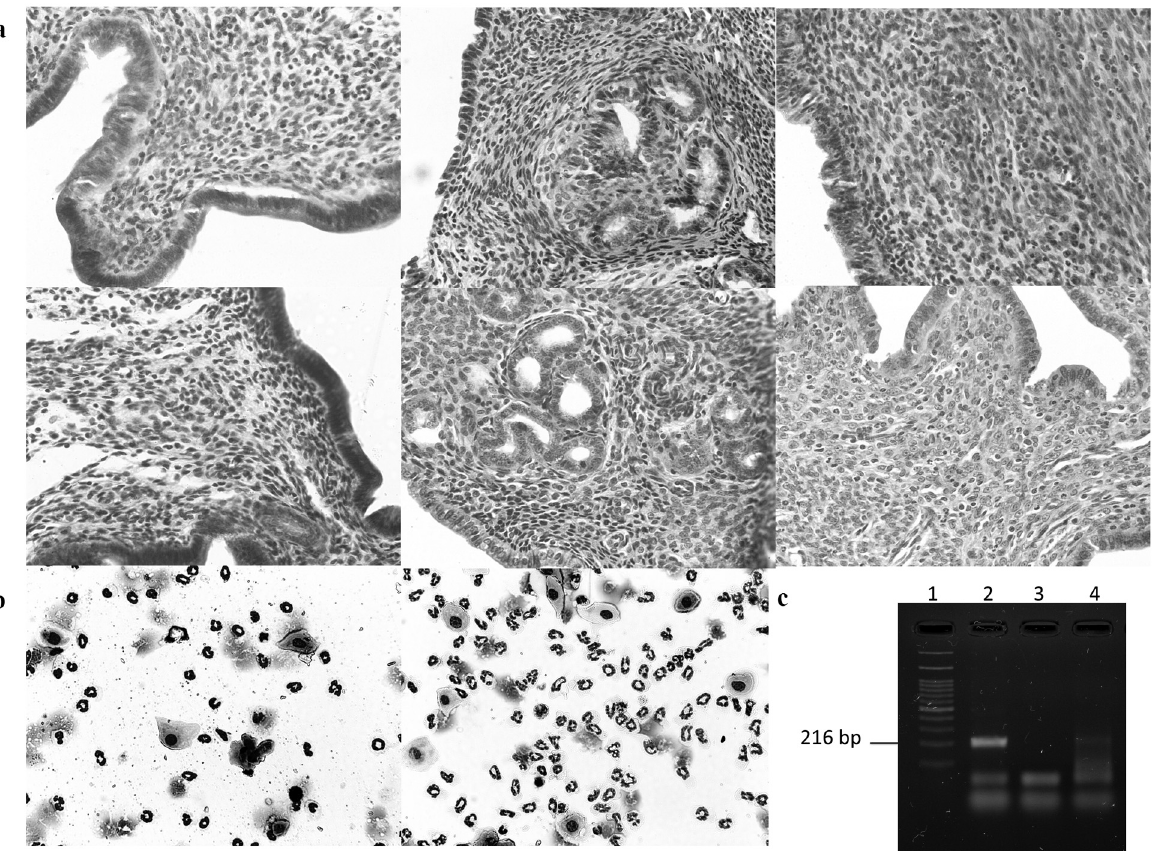
Figure 2 - Cytological analysis and detection of U. diversum . A/J mice were infected with 10 4 CCU of U. diversum intrauterine route. ( a ) Twenty four, 48 and 78 hours after infection the animals had uterus fi xed in 10% formalin. The slides were prepared and subsequently stained with hematoxylin and eosin. Photomicrographies upper and lower show control and infected animals 24, 48 and 72 hours respectively, 400X ( b ) Vaginal lavage of control and infected mice 24 hours after infection respectively, 400X magni fi cation. ( c ) U. diversum detection by PCR. Animals infected by U. diversum had genomic DNA extracted from uterine tissue and ampli fi ed by PCR. The products of PCR ampli fi cation using the primers UD3 (5 ′ -AAT GTC GGC TCG CTT ATG AG-3 ′ ) and UD4 (5 ′ -CCT GTC ATA TTG TTA ACC TCC GC-3 ′ ) were analyzed by agarose gel electrophoresis. The presence of a 216 bp DNA fragment indicated the speci fi c detection of U. diversum. 1. Lader; 2. Positive control; 3. Negative control; 4. Infected 10 4 after 72